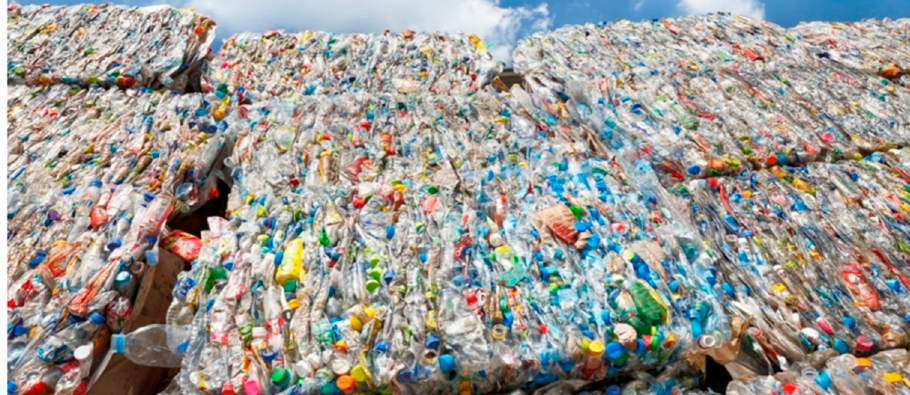
through an X-ray fluorescence (XRF) test. This test result revealed that the PET waste herein consisted of butylene, ethylene, and propylene with its dry density varying within 910 and 913 kg/m 3 in conformance with ASTM D792 [33] protocol.